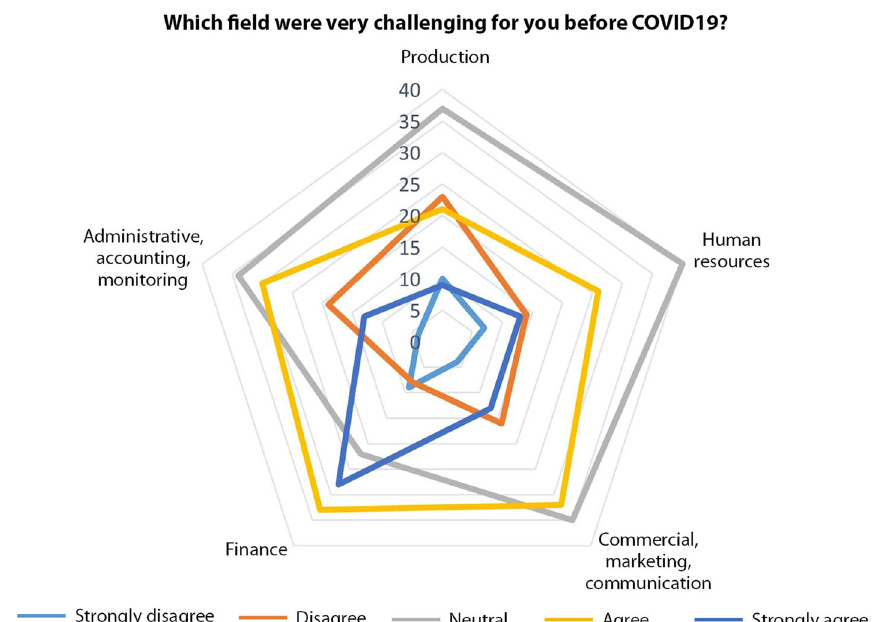
Fig. 12 challenging fields before COVID-19 (Source: the authors)